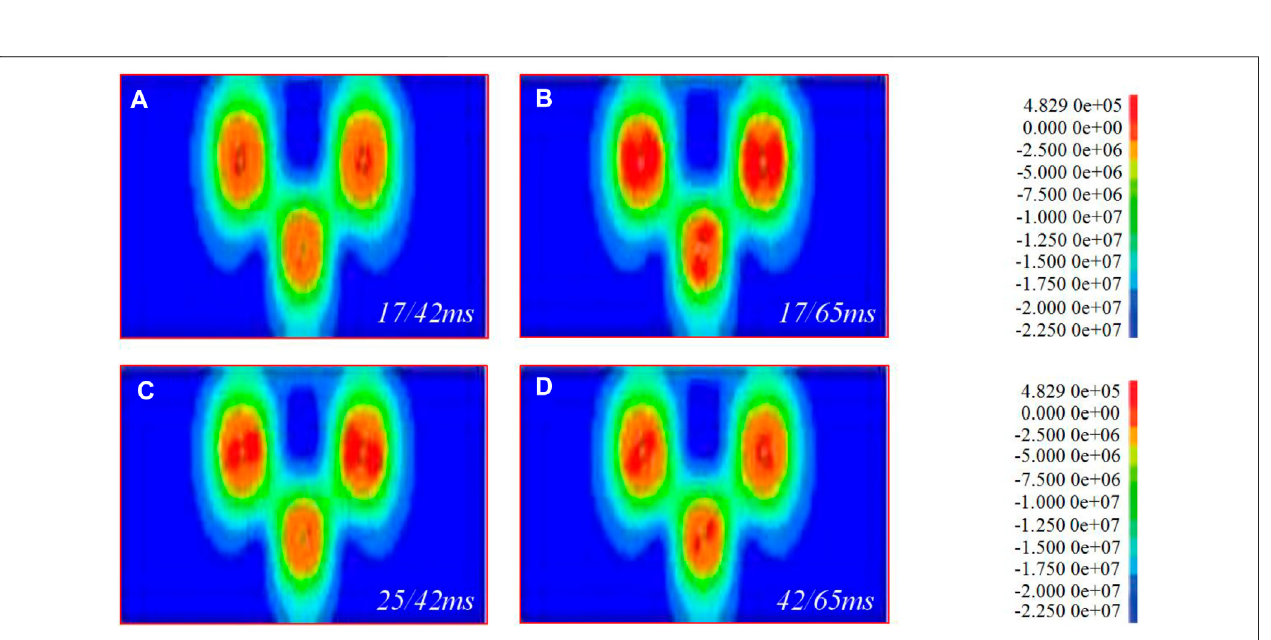
analysis ( Table 2 ). The comparison results show that: 1) According to the safety allowable vibration speed standard for permanent rock high slopes, the on-site slope vibration speed standard control is determined to be 5 cm/s. However,